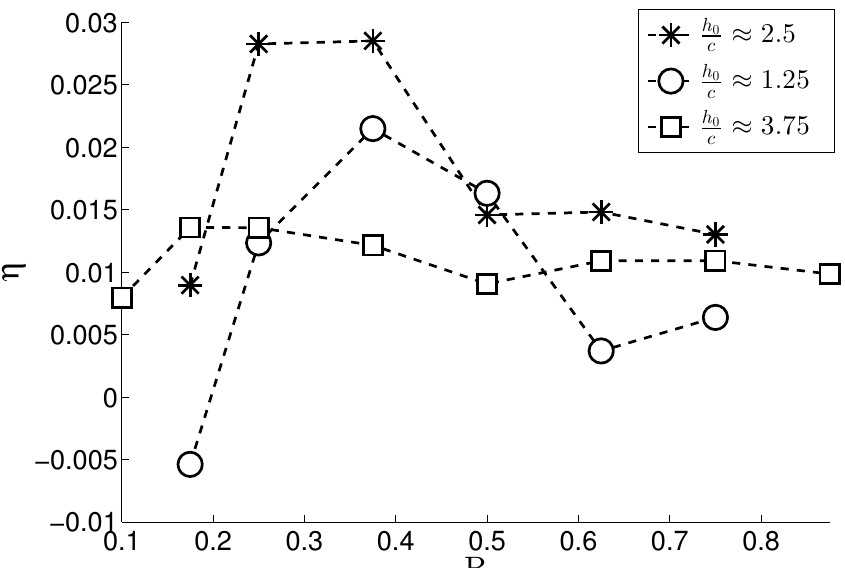
Figure 10. Re = 1000. η vs. B . Markers correspond to different values of h 0 / c : circles: h 0 / c = 1.25; squares: h 0 / c = 3.75; asterisks: h 0 / c = 2.5.